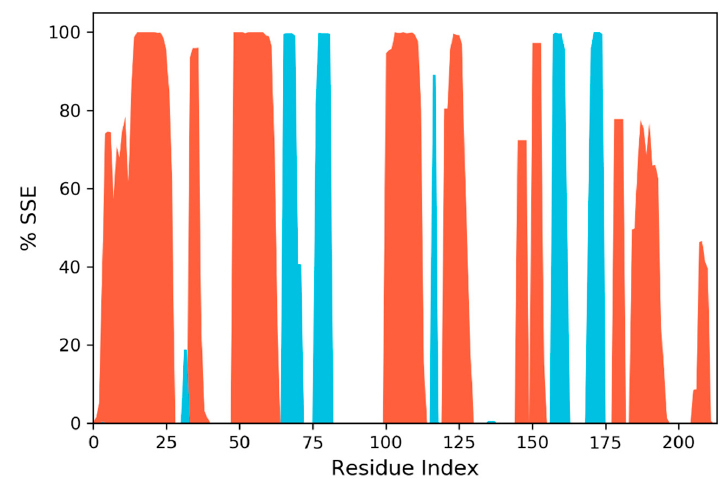
Figure 11. Protein secondary structure histogram .